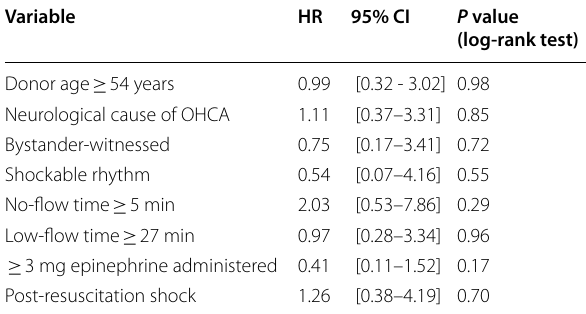
Table 2 Univariate analysis of variables associated with 1-year graft survival